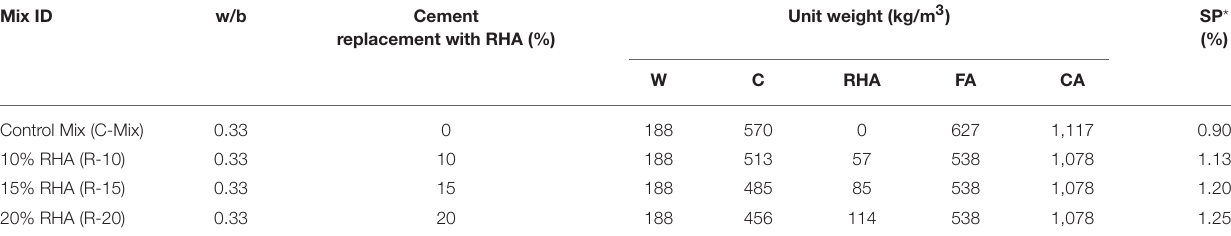
TABLE 6 | Mix proportion of control concrete and concretes containing different percentages of RHA. Mix ID w/b Cement replacement with RHA (%)